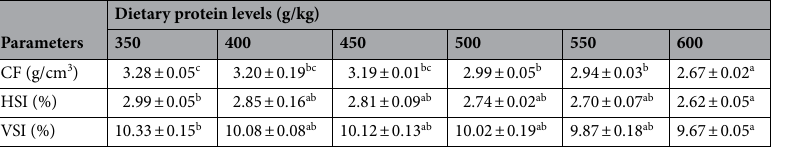
Table 2. Effect of dietary protein level on morphological indices of juvenile orange-spotted grouper. Values in the table are means ± SD (n = 3). Values in the same line with different superscripts indicate significant difference ( P < 0.05). CF condition factor, HSI hepatosomatic index, VSI visceralsomatic index.